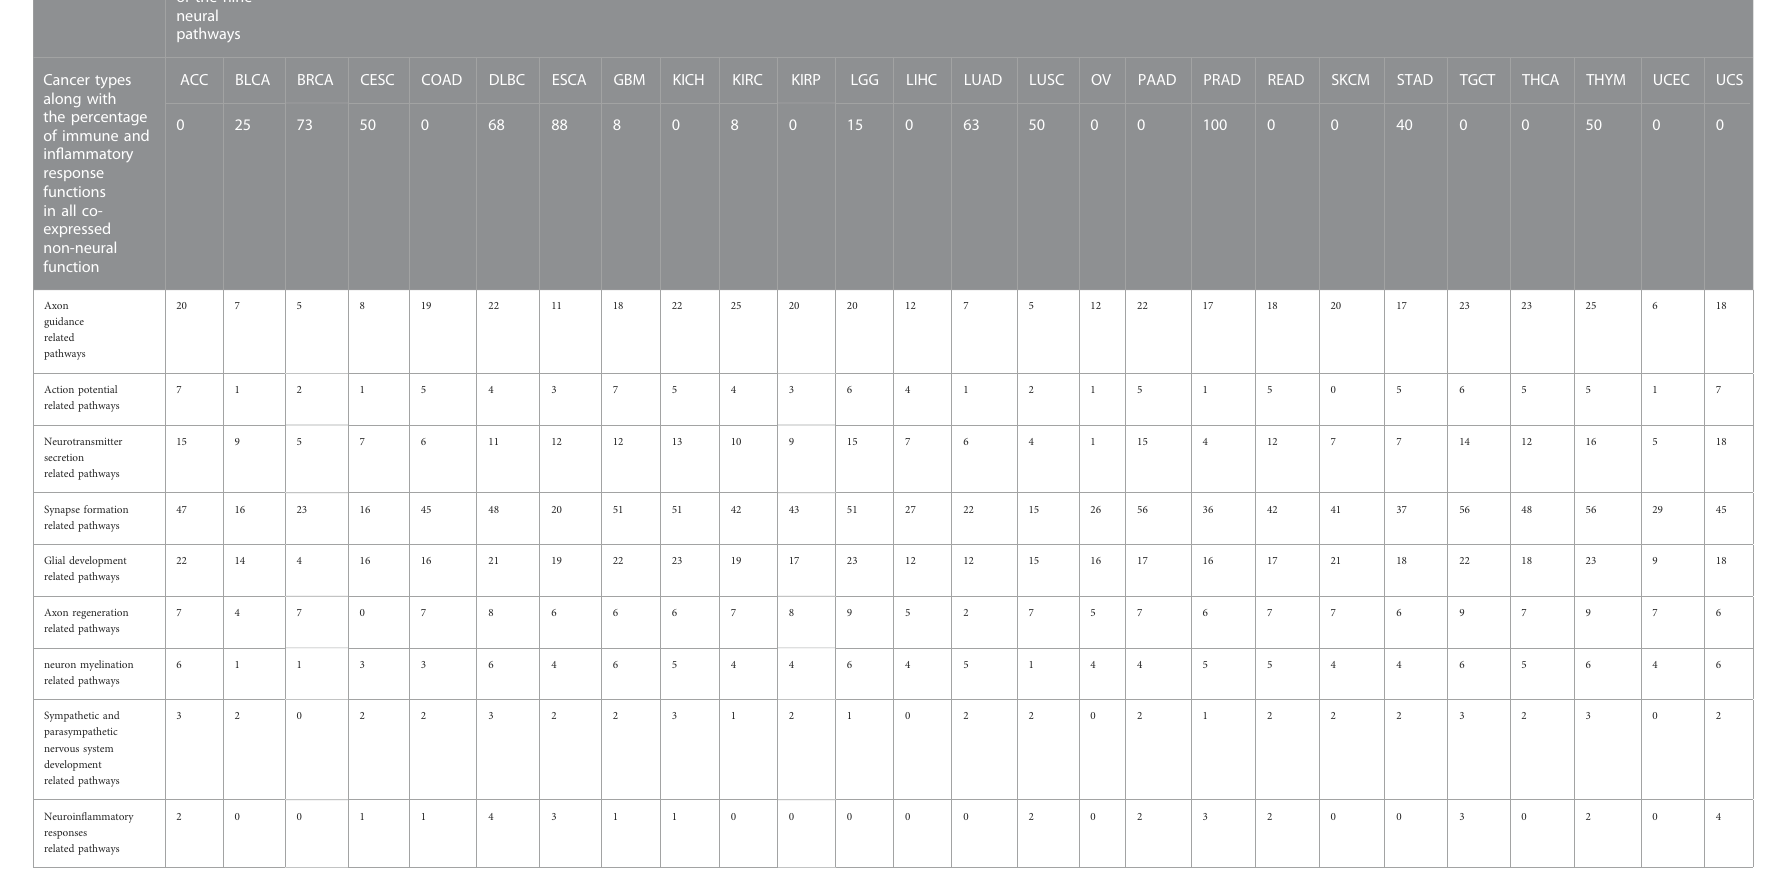
TABLE 1 Effects of nine neural functions on immune responses. Neural